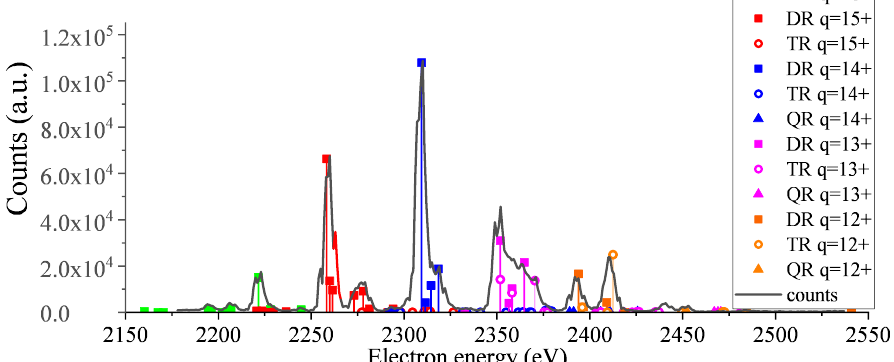
Figure 5. The projection of the spectrum of the K-LL radiation structure on the electron energy axis. The measurement time was 241.5 h. The calculated resonance strength was plotted on the top of the experimental result. Each group of resonances calculated for the selected charge state was scaled with an appropriate factor to obtain an agreement, as shown in the plot. This allows for the identification of the charge state of the active